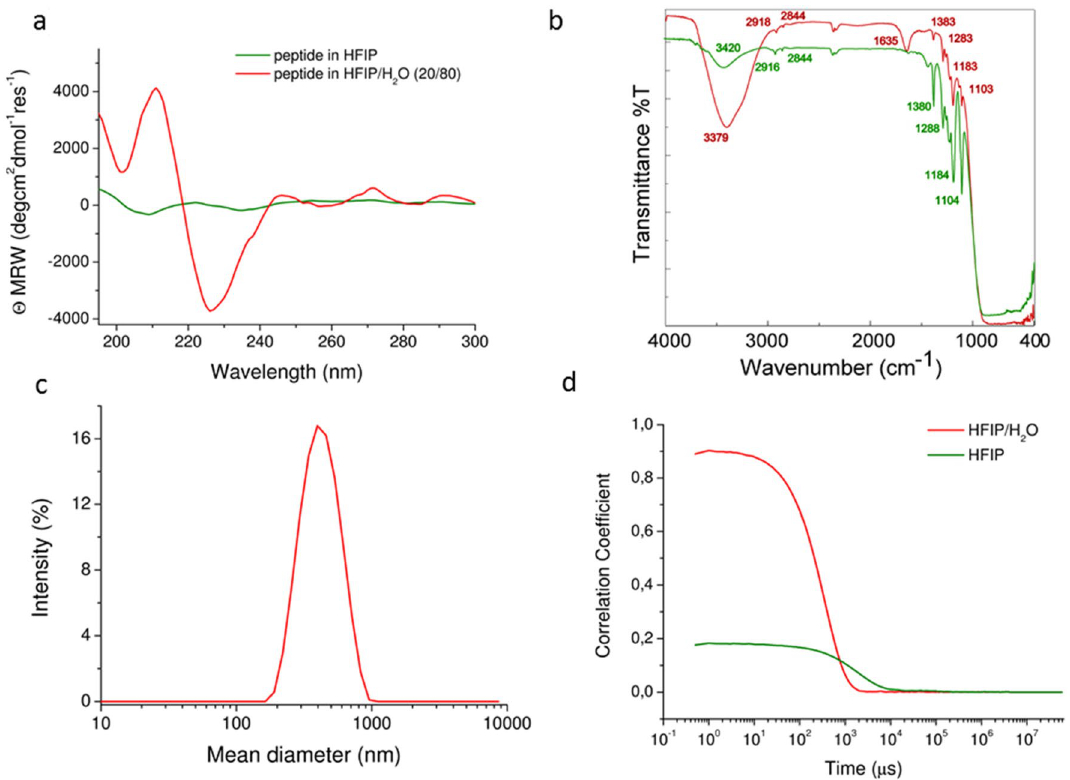
Figure 2. Structural characterization of Rho-PEG1300-F6 in solutions. ( a ) CD spectra of Rho-PEG1300-F6 in HFIP at a concentration of 5 × 10 −3 M and in HFIP/H 2 O (20/80) at a concentration of 1 × 10 −3 M. ( b ) FTIR spectra of the peptide in HFIP (green line) and in HFIP/H 2 O (red line) at a concentration of 5 × 10 −3 M and 1 × 10 -3 M. ( c ) DLS profile of Rho-PEG1300-F6 in HFIP/H 2 O at a concentration of 1 × 10 −3 M. ( d ) Correlation functions of the peptide in HFIP and in HFIP/ H 2 O